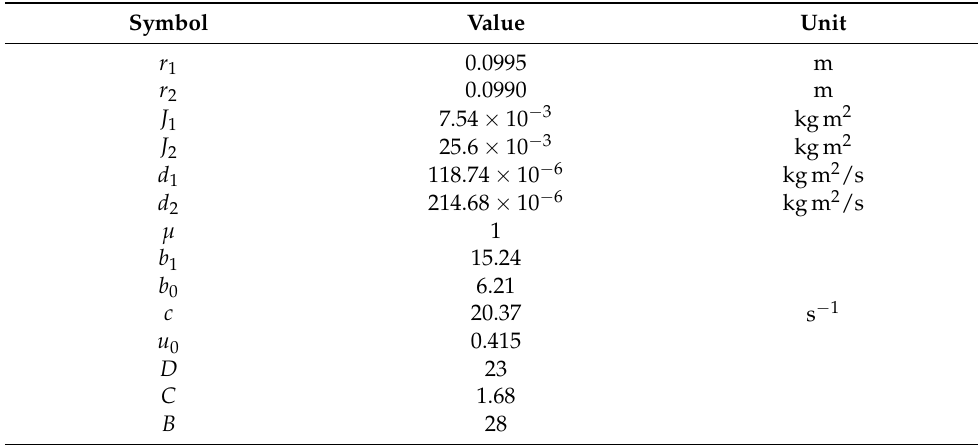
Table 1. Parameters of the experimental